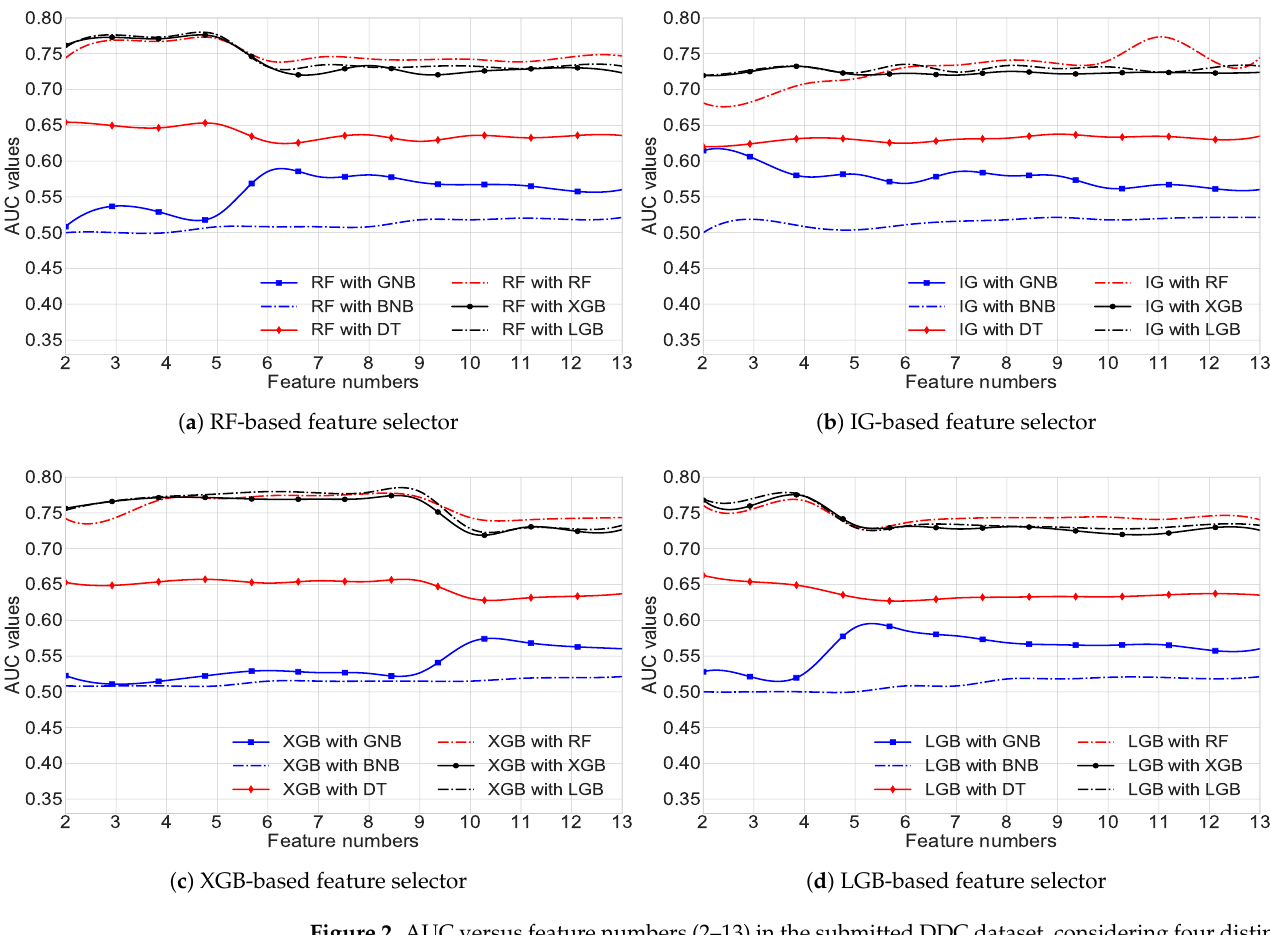
Figure 2. AUC versus feature numbers (2–13) in the submitted DDC dataset, considering four distinct feature-choosing approaches and six different ML-based